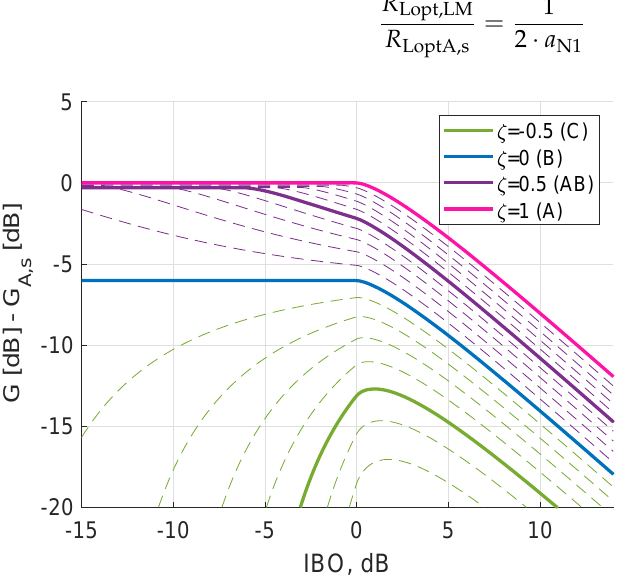
Figure 12. Linearity for different biasing classes. Dashed lines are other intermediate class-AB (purple) and class-C (green)